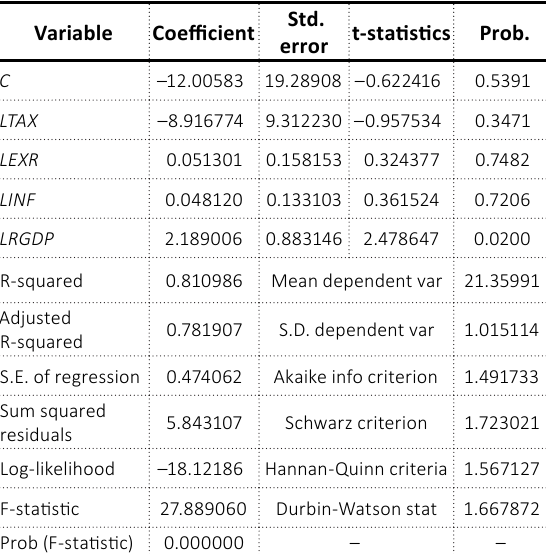
Table 7. Ordinary least square regression